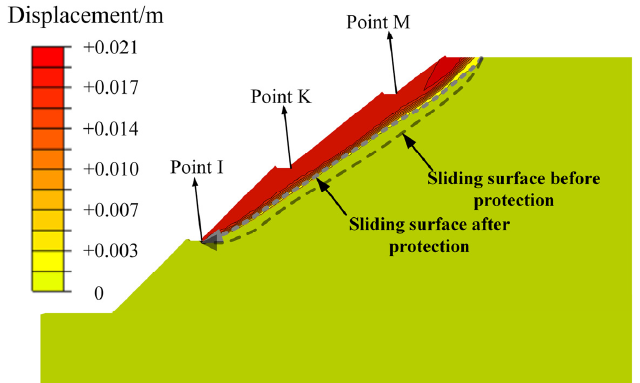
Figure 16. Failure mode of the protected slope after rainfall